Question: Express in one sentence what the figure is showing.
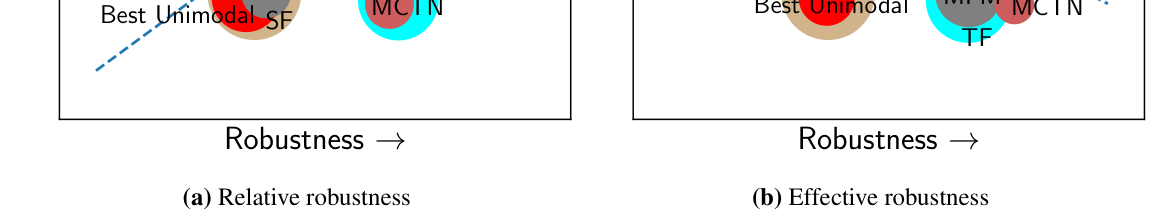
Answer: 5: Relative performance of each model across different domains. We find that the performance of multimodal models varies significantly across datasets spanning different research areas and modalities. Similarly, the best-performing methods on each domain are also different. Therefore, there still does not exist a one-size-fits-all model, especially for understudied modalities and tasks.